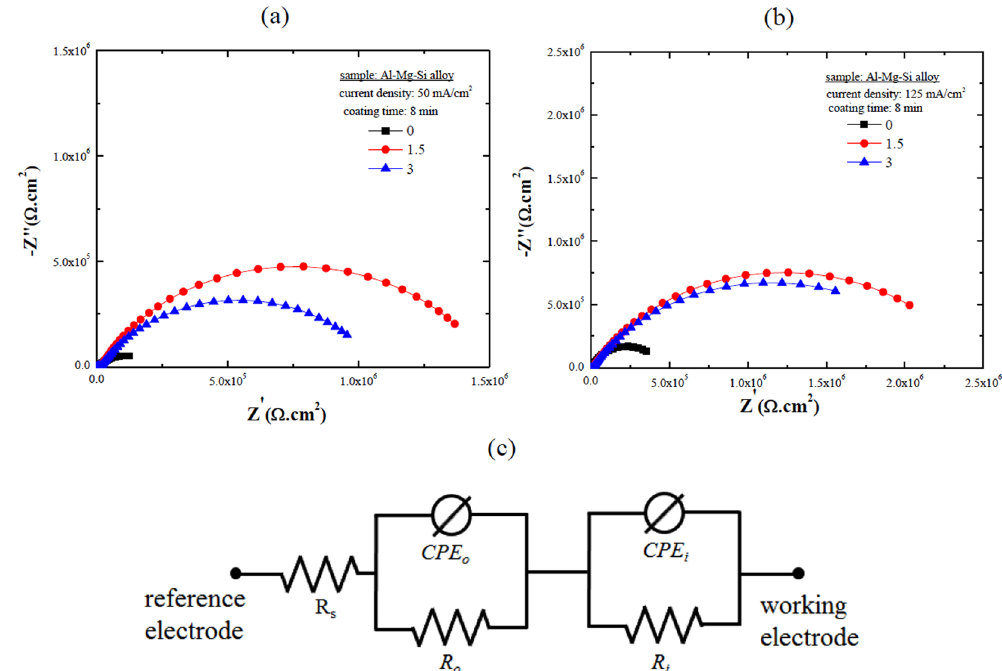
Figure 6. Nyquist plots recorded in 3.5 wt.% NaCl solution of the coatings formed on an Al-Mg-Si alloy by PEO at ( a ) 50 mA/cm 2 and ( b ) 125 mA/cm 2 using electrolytes containing different concentrations of Na 3 AlF 6 and ( c ) the equivalent circuit model used for analyzing the EIS data of the coatings formed in the electrolyte containing Na 3 AlF 6 with different concentrations at two different current densities, where R s is the resistance of the solution, R o and R i is the resistance of the outer and inner layers of the coatings, respectively, and CPE o and CPE i is the constant phase element of the outer and inner layers,